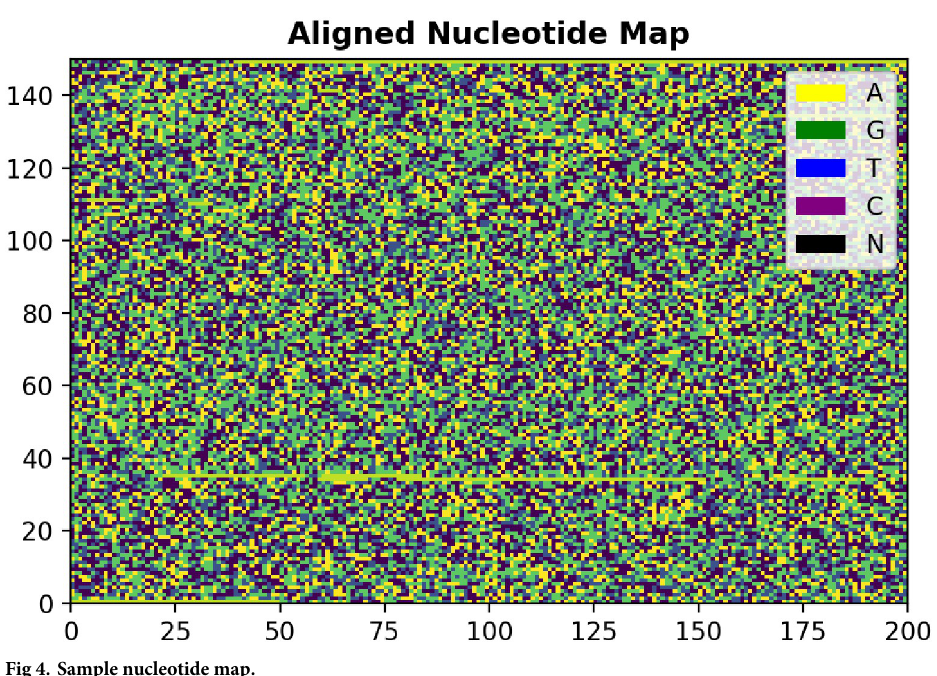
Fig 4. Sample nucleotide